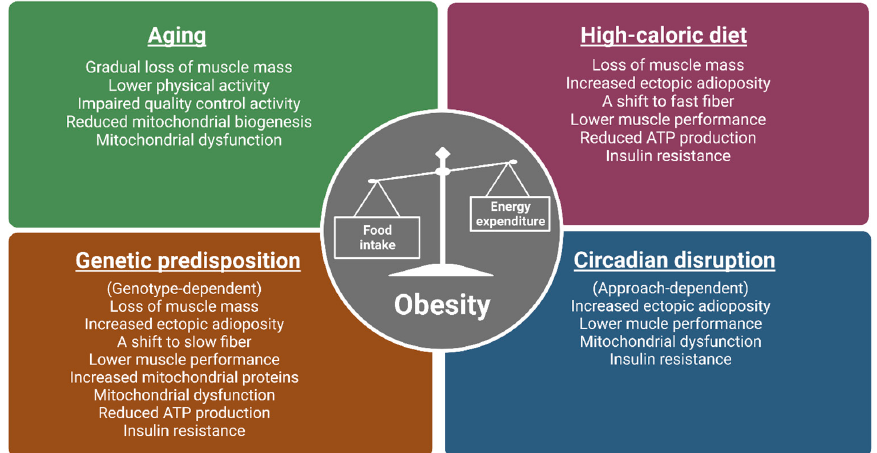
Figure 1. The impacts of various obesogenic challenges on skeletal muscle structure, function, and energy metabolism. Major causes of obesity include aging, a lifestyle of chronic high-calorie diets, genetic predisposition, and circadian disruption. Studies from human and animal models (mice and flies) show that the above-mentioned obesogenic challenges have common and distinct impacts on skeletal muscle structure, function, and metabolism. As muscle phenotypes are genotype-dependent in genetically obese models, only observations from ob/ob, M4RKO mutant mice, and Sk 2 flies are included. Moreover, as circadian disruption can be induced by light, feeding patterns, and clock gene manipulation, muscle phenotypes can be approach dependent. Images created in